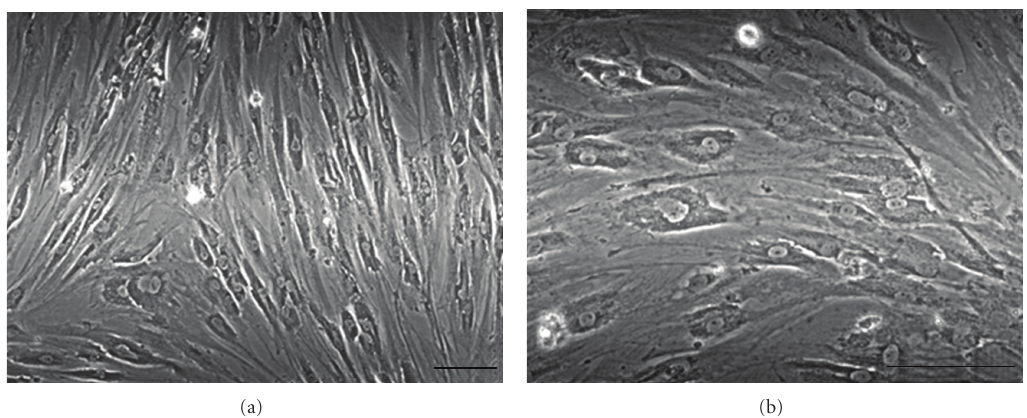
Figure 2: Human bone-marrow-derived mesenchymal stem cells in culture (scale bar = 100 microns).